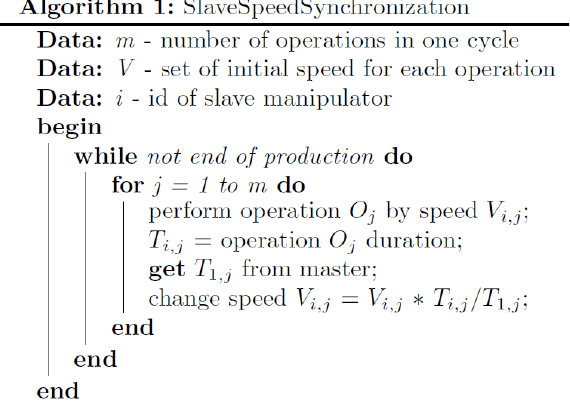
Figure 2. Basic algorithm for synchronization of robotic cell operations.